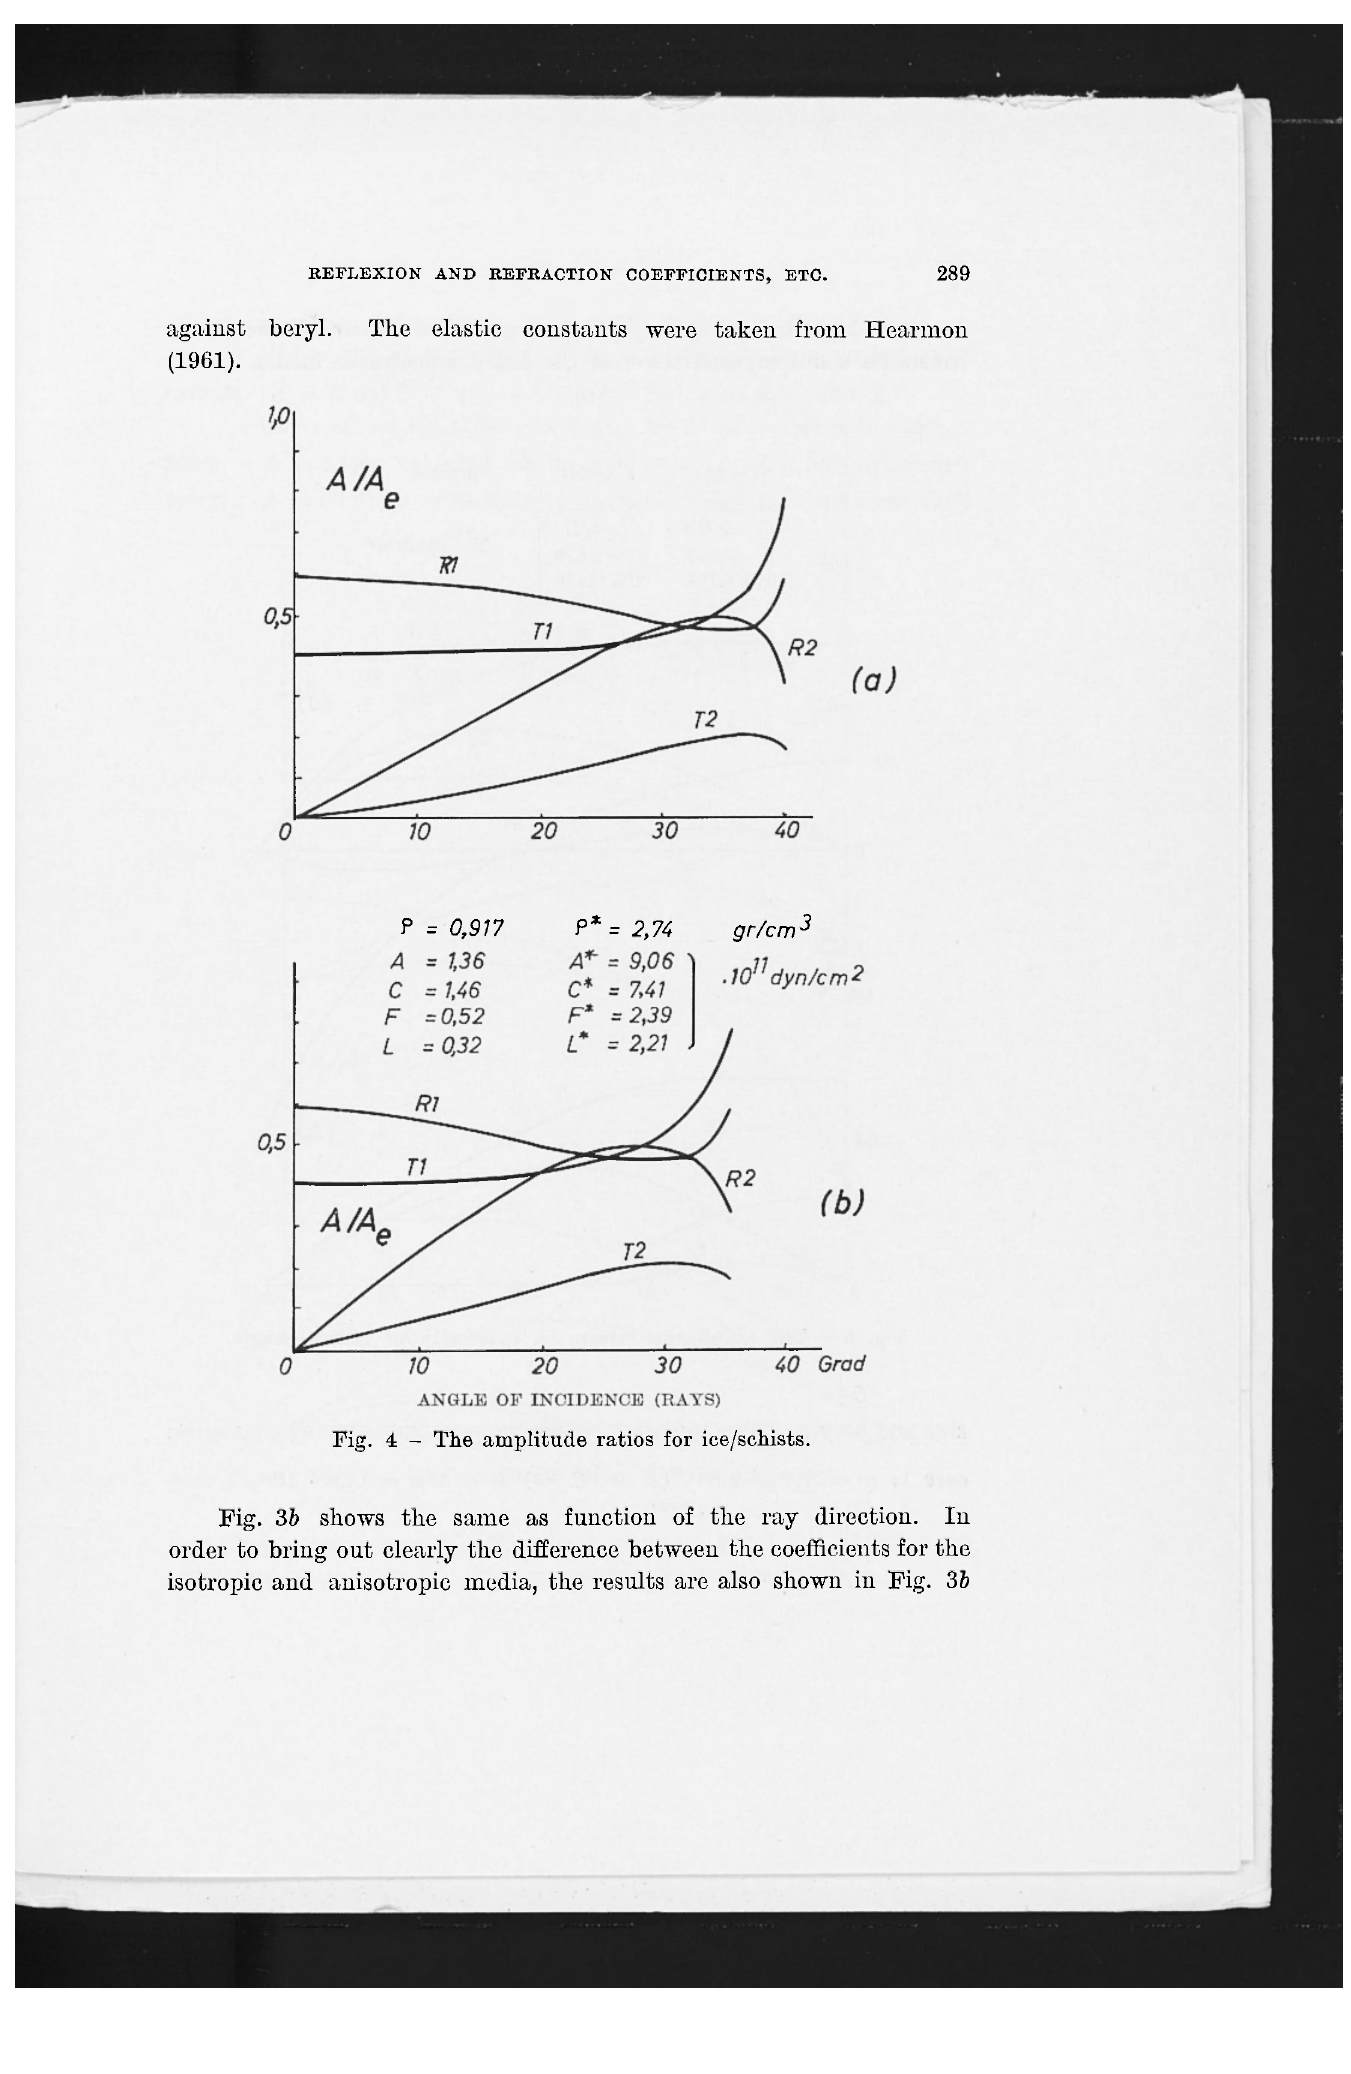
Pig. 3b shows the same as function of the ray